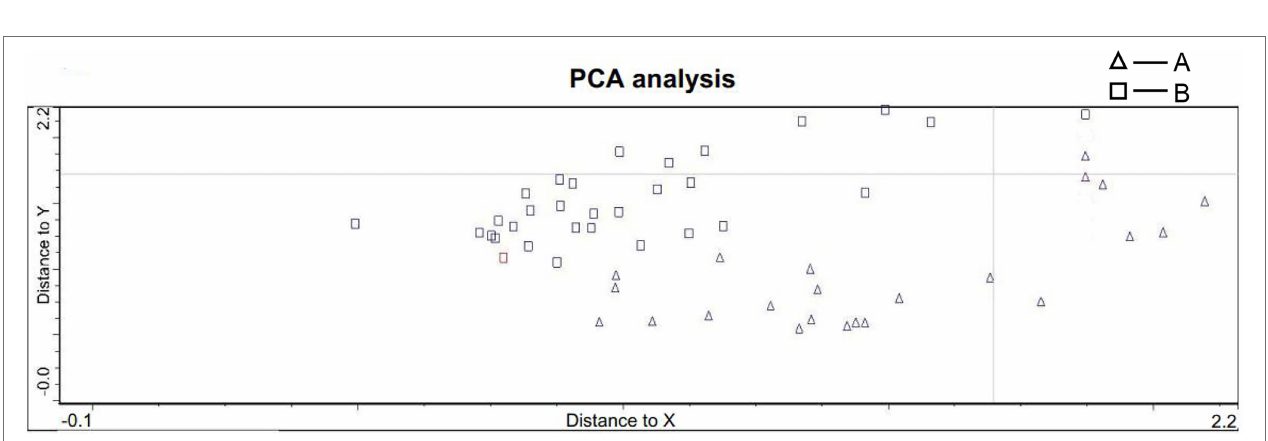
FIGURE 4 | PCA statistics of sperm spectra. The sperm were divided into two groups: group A included 22 sperm, and group B included 31 sperm (A: triangle B: